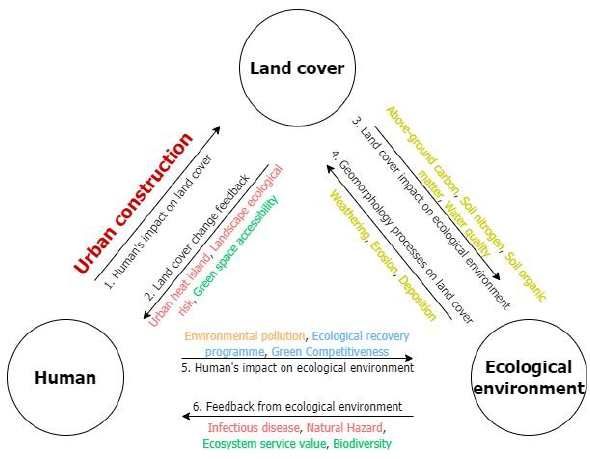
Figure 1 . Key topics under the scope of